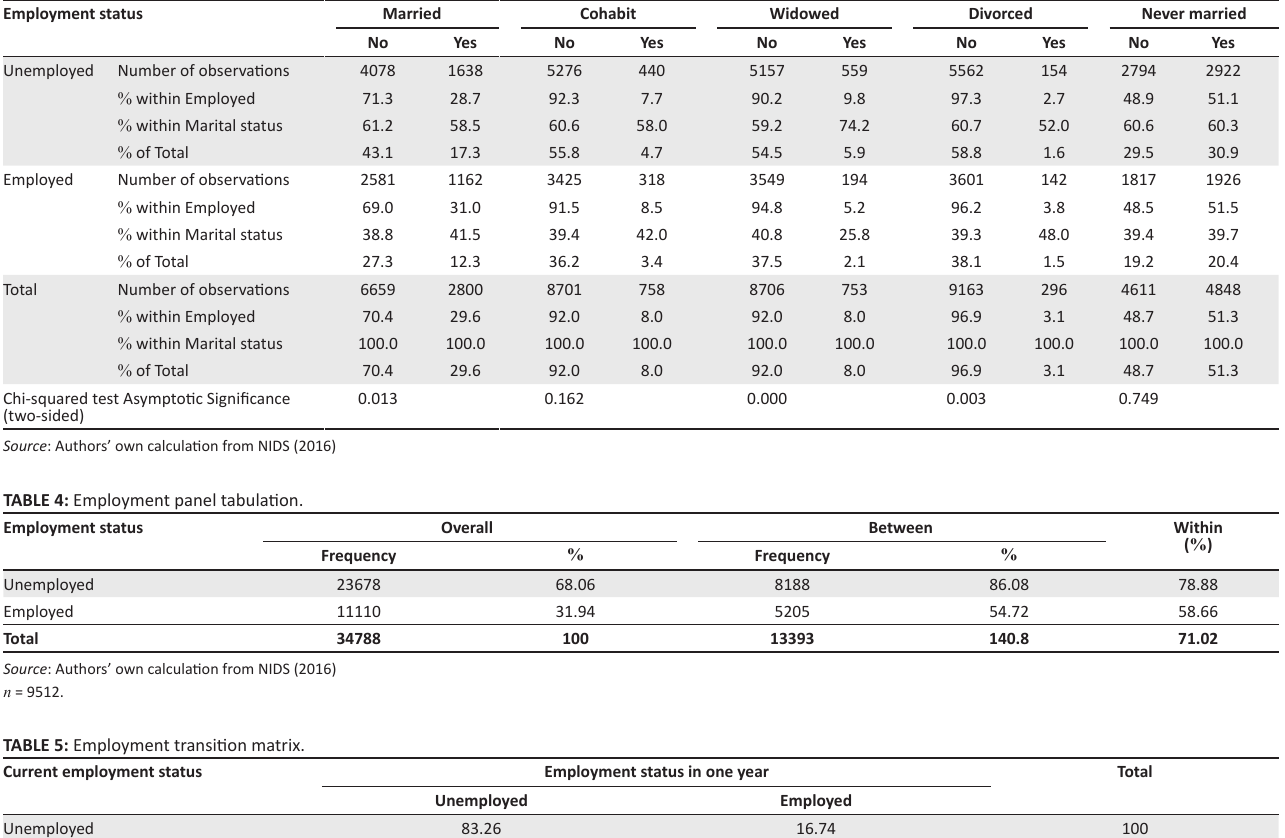
TABLE 3: Employed and marital status cross-tabulation for 2014.